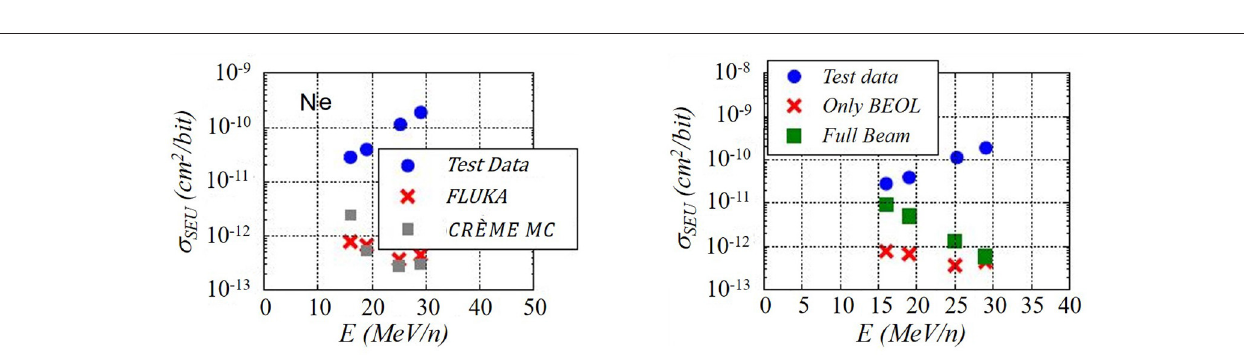
FIGURE 8 | Comparison of FLUKA simulations of heavy ion irradiations of the ESA SEU Monitor with experimental data [21]. Reproduced with permission from IEEE.